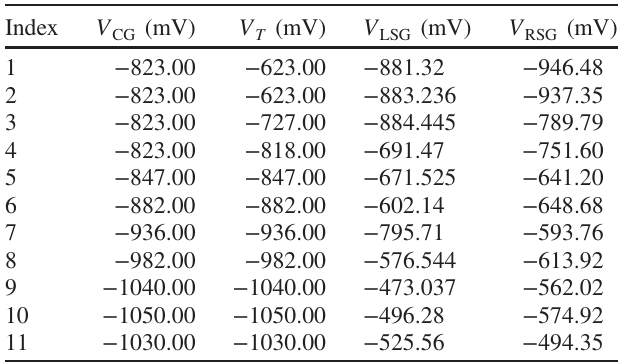
TABLE II. The DQD gate voltages for the 11 configurations investigated in Sec. III in the main